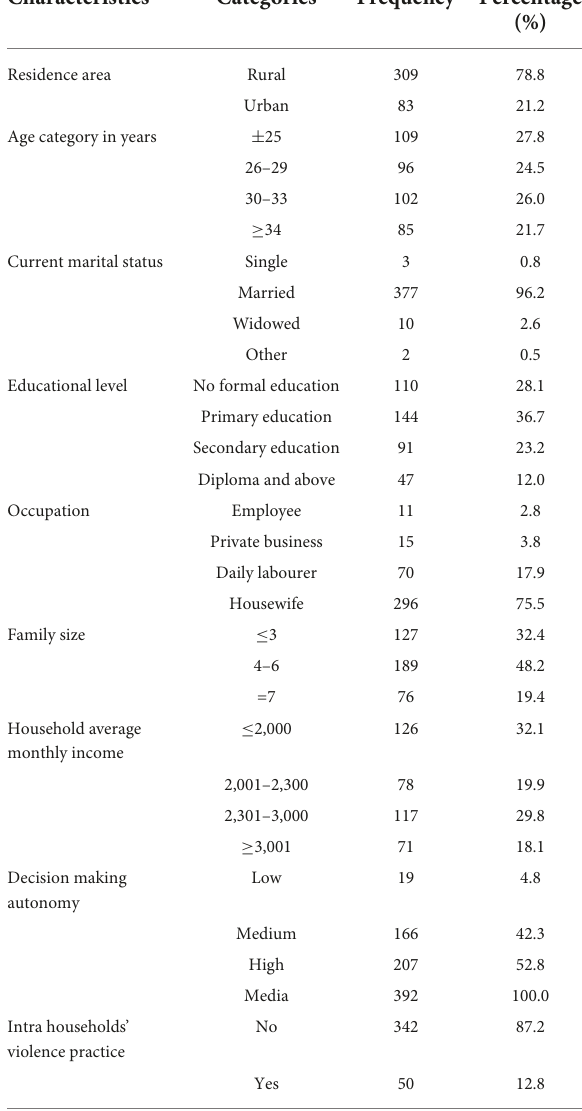
TABLE 2 Socio-demographic, and socio-economic characteristics of study participants ( n = 420), 2021.